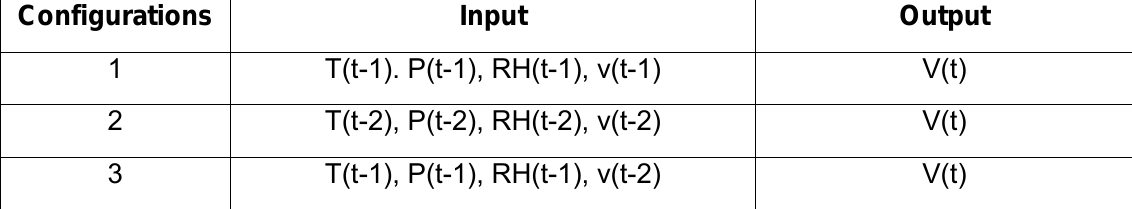
Table 1. Presentation of the different configurations of the prediction models Configurations